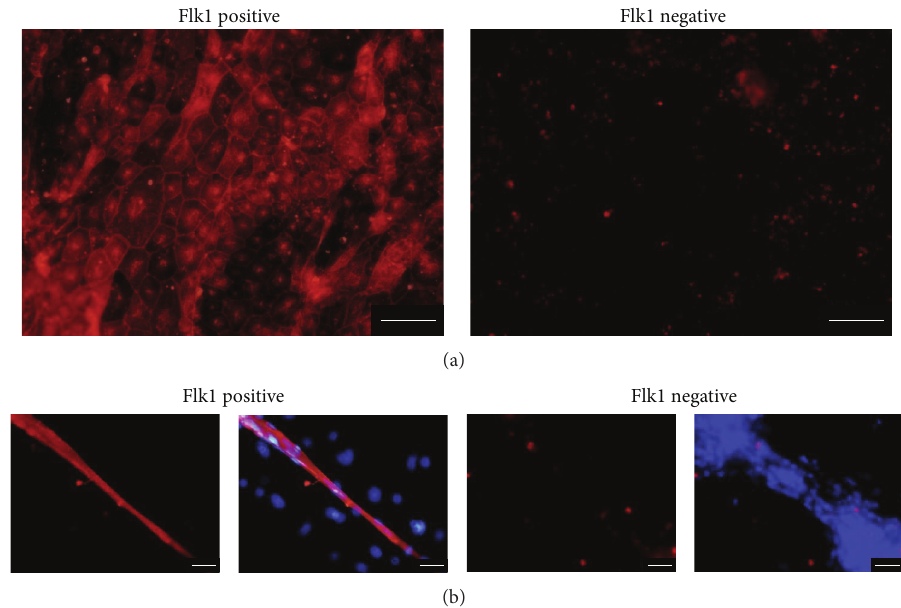
Figure 4: Tube forming assay of angioblast-like cells induced from ES cells (ES-ABs) on Matrigel. To elucidate whether ES-ABs themselves are enabled to form blood vessels, sorted ES-ABs and Flk1 negative cells were, respectively, seeded on Matrigel. Two days later, cells were visualized with isolectin IB4, a stain of endothelial cell. (a) Although endothelial cells stained with IB4 were rarely induced from Flk1 negative cells (right), heavy numbers of endothelial cells were induced from ES-ABs and deployed cobblestone-like pattern (left). Bar: 100 𝜇 m. Red: isolectin IB4. (b) In ES-AB culture, a part of cells stained with IB4 structured vessel like tube formation (left 2 images). On the other hand, cells forming a line were not stained with IB4 in culture of Flk1 negative cells (right 2 images). Bar: 100 𝜇 m. Red: isolectin IB4 and blue: DAPI.